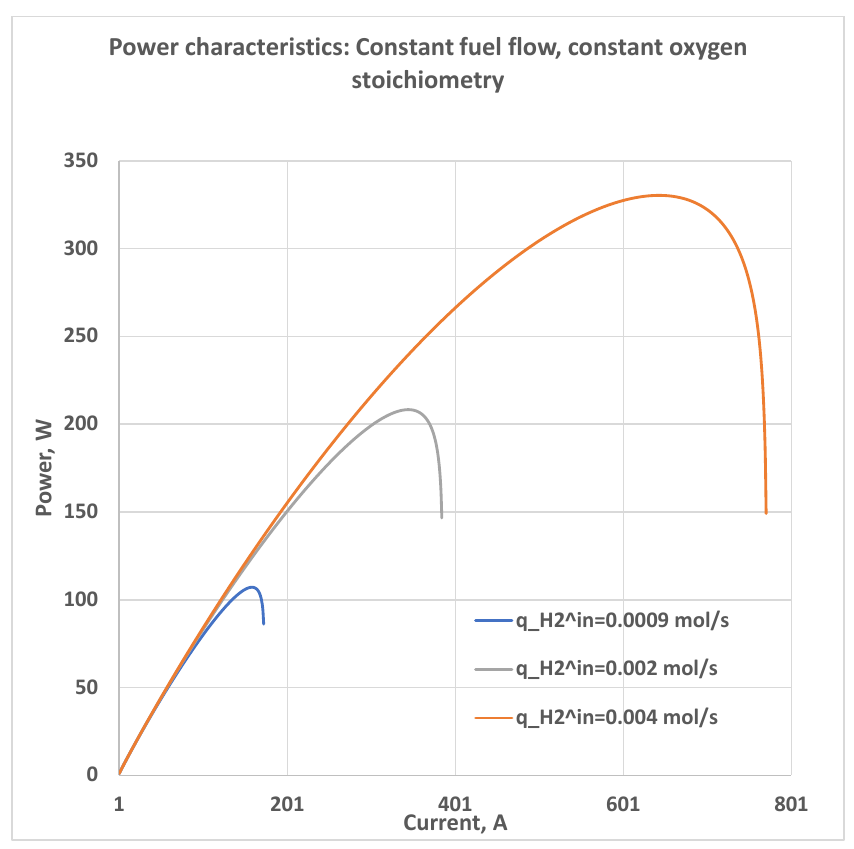
Figure 13. Effect of the fuel flow rate on the power-versus-current behavior (constant hydrogen flow and constant oxygen